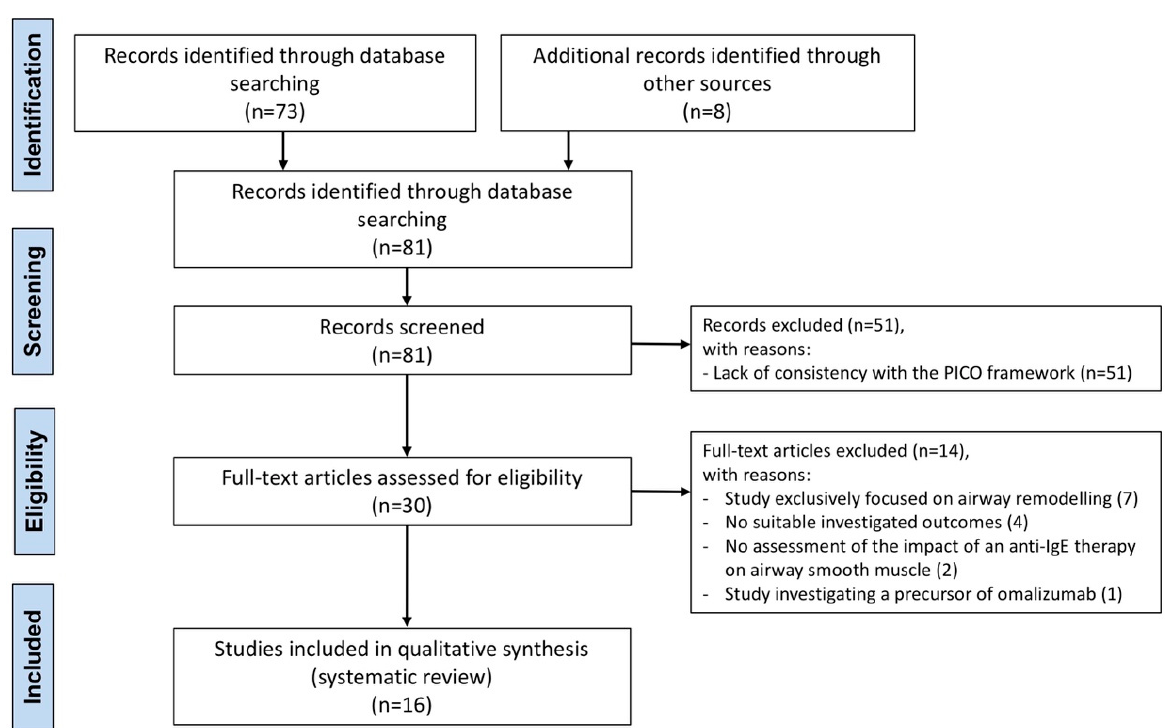
Figure 1. PRISMA flow diagram for the identification of the studies included in the systematic review concerning the impact of mAbs for the treatment of asthma on the airway smooth muscle. IgE: immunoglobulin E; mAbs: monoclonal antibodies; PICO: Patient problem, Intervention, Comparison, and Outcome; PRISMA: Preferred Reporting Items for Systematic Reviews and Meta-Analysis.